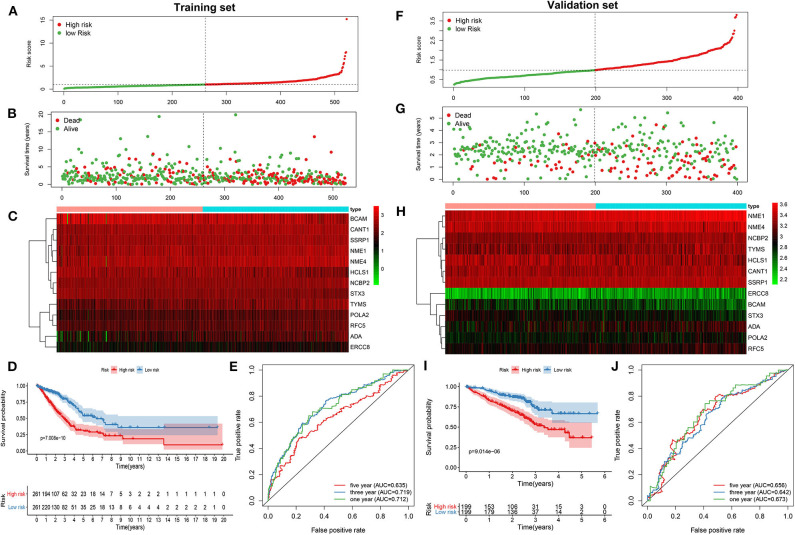
Construction and verification of a prognostic model for LUAD patients according to 13 DNA repair-related genes. In the training set, (A) the distribution of the risk scores among all LUAD samples. According to the median value (dotted line), LUAD samples were divided into high- (red dot) and low- risk (green dot) groups. (B) The distribution of survival status of all LUAD samples. Red dot is indicative of dead status and green dot indicates alive status. (C) Heat map depicting the expression patterns in the 13 DNA repair genes between high- and low- risk groups. (D) Kaplan-Meier survival curve demonstrating the OS differences between high- and low- risk groups. (E) The ROC curves for 1-, 3-, and 5-year OS. In the validation set, (F) the distribution of the risk scores among all LUAD samples. (G) The distribution of survival status of all patients. (H) Hierarchical clustering heat map depicting the expression differences in the 13 DNA repair genes between high- and low- risk groups. (I) Kaplan-Meier survival curve showing the OS differences between the two groups. (J) The ROC curves for 1-, 3-, and 5-year OS.